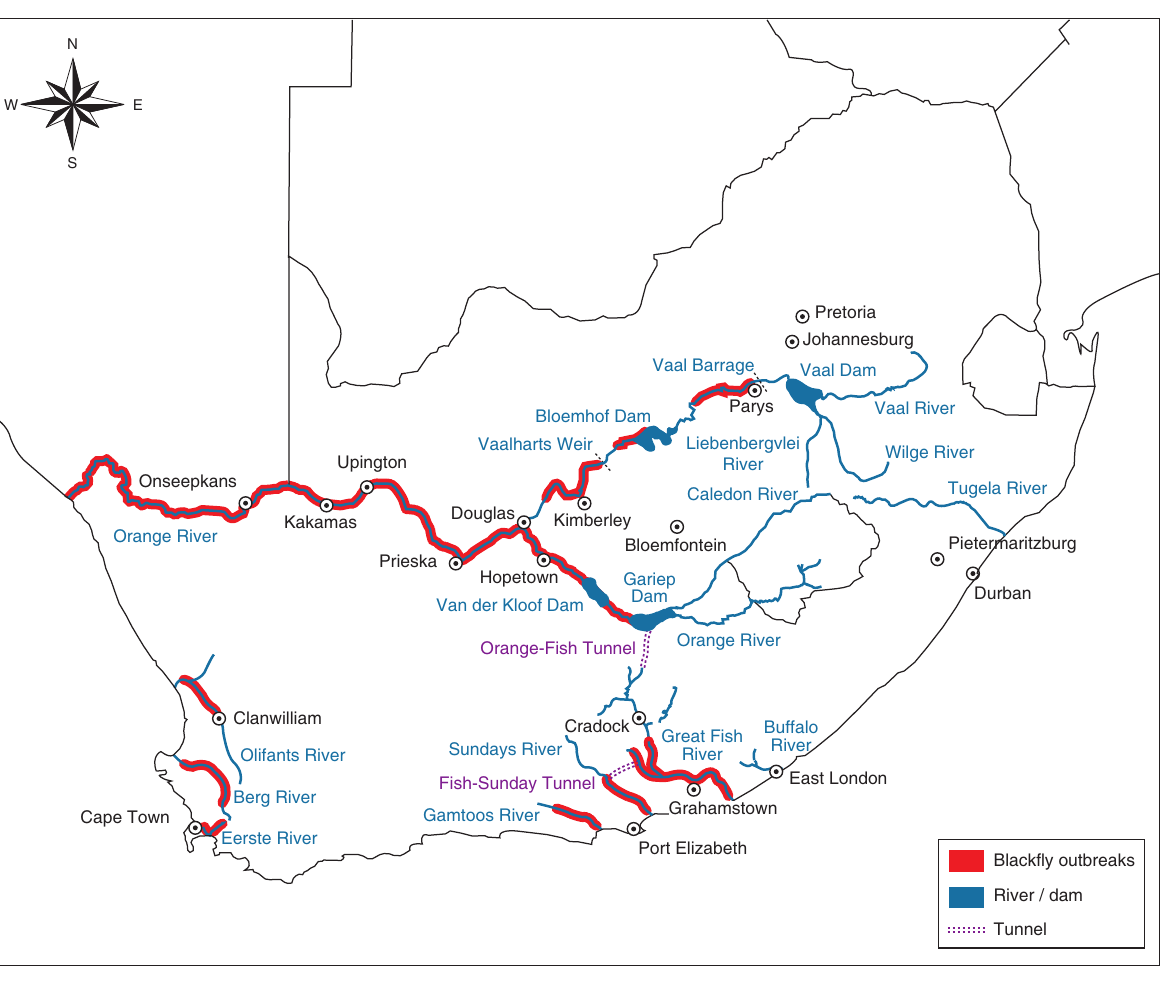
FIG. 1 Known blackfly problem areas in South